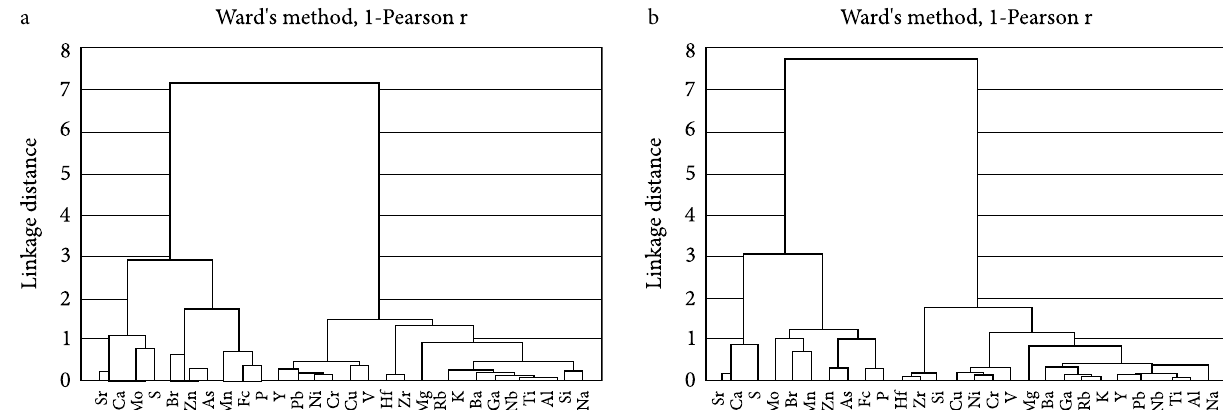
Fig. 7. Dendrograms of anomalous As (a) and anomalous Mo (b) data sets (Fc means